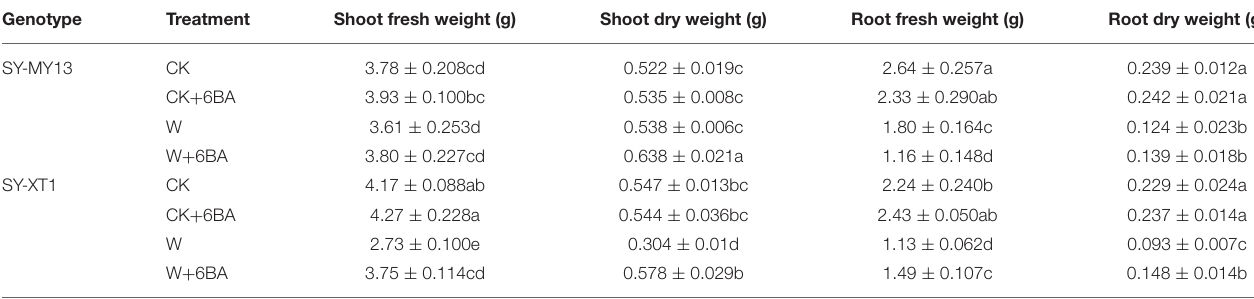
TABLE 1 | Effects of 6-benzyladenine (6-BA) on the biomass of two waxy corn inbred lines experiencing waterlogging stress.